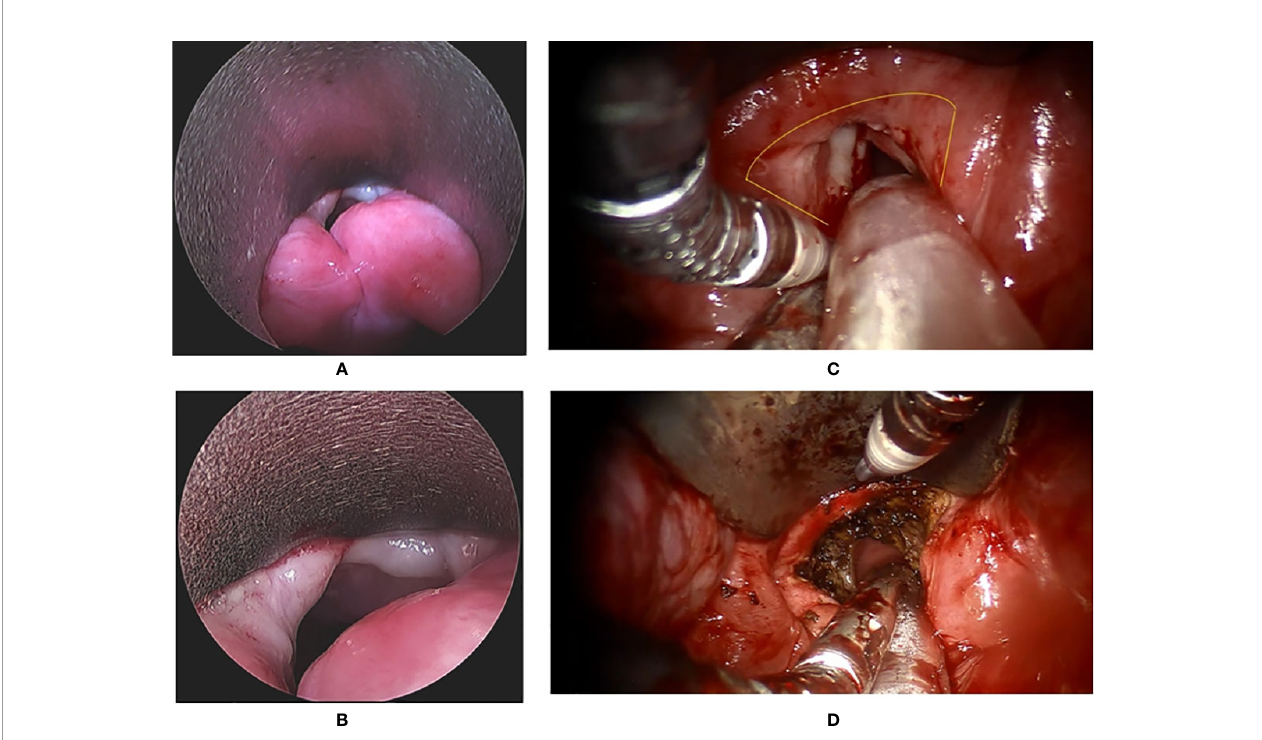
FIGURE 1 | The endoscopic view of a patient with recurrent glottis cancer with AC involvement after radiation failure during conventional TLM biopsy and TORS. (A) Zoom-out view of TLM with limited exposure of AC and false vocal folds. (B) Zoom in view of TLM with limited exposure. (C) Zoom-in view of TORS with panoramic exposure of AC and bilateral false vocal folds. The yellow line indicates the planned resection margin. (D) Zoom-out view of TORS after the cancer involving AC and false vocal folds was resected.